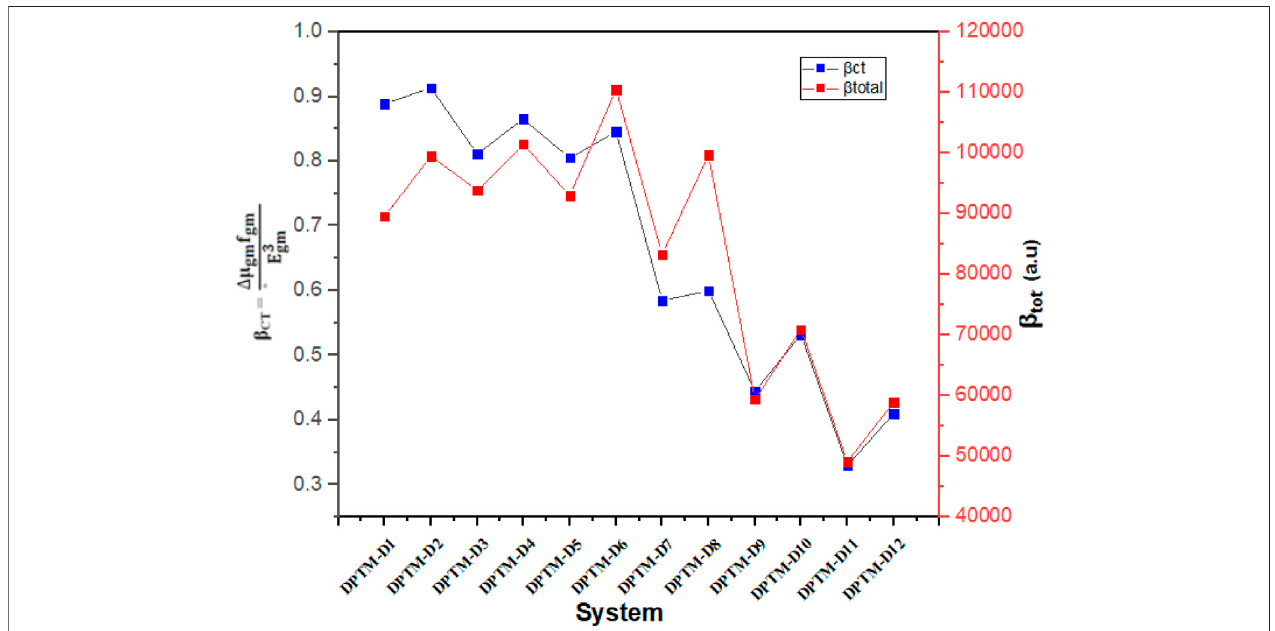
FIGURE 5 | Relation between the β total values and the consistent β CT values of the investigated compounds (DPTM-1 to DPTM-12).